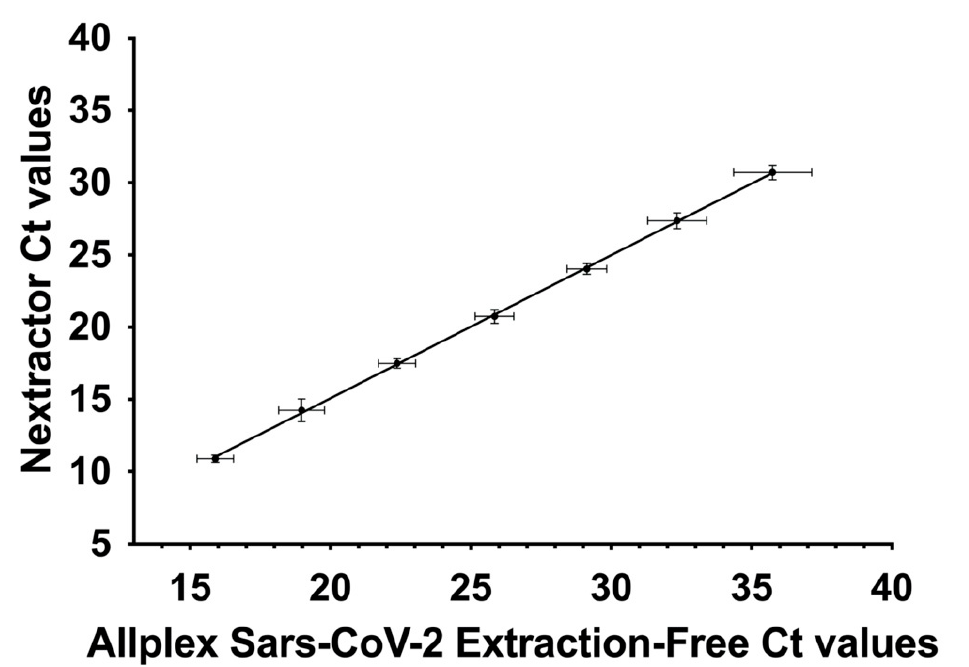
Figure 2. Correlation between Ct values obtained with preliminary RNA extraction (Nextractor) and the extraction-free protocol (Allplex SARS-CoV-2 Extraction-Free). Ct values are presented as the mean of six replicates for each dilution ± SE.